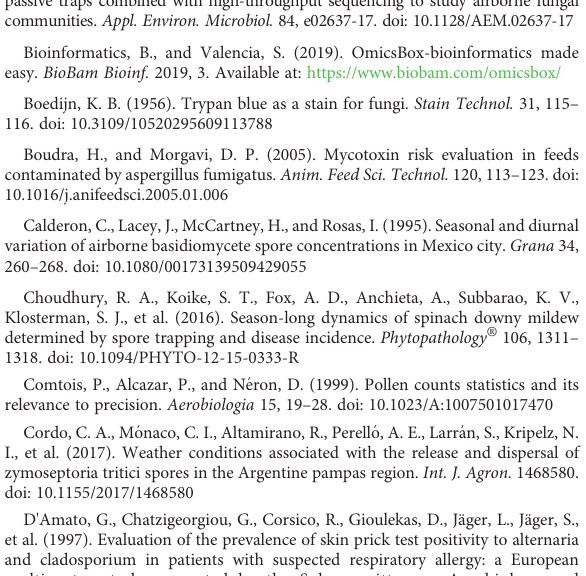
SUPPLEMENTARY FIGURE 1 Cladogram tree of BLAST species hits distribution; each node contains 12 boxes representing the 12 samples (3 monthly samples for the four UK wheat fi eld sites). Color shading of the boxes indicates the percentage of BLAST hits relative abundance in that speci fi c clade for the speci fi c sample. The white colour represents 0% increasing through green